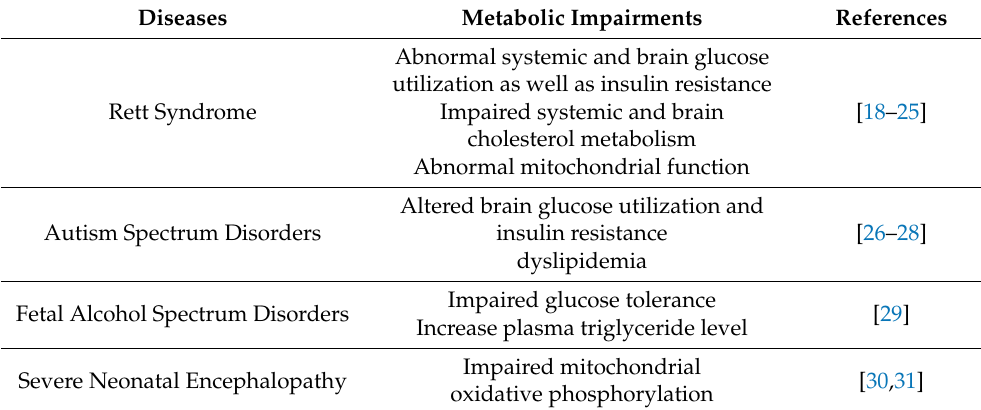
Table 1. MeCP2-linked neurodevelopmental disorders and metabolic